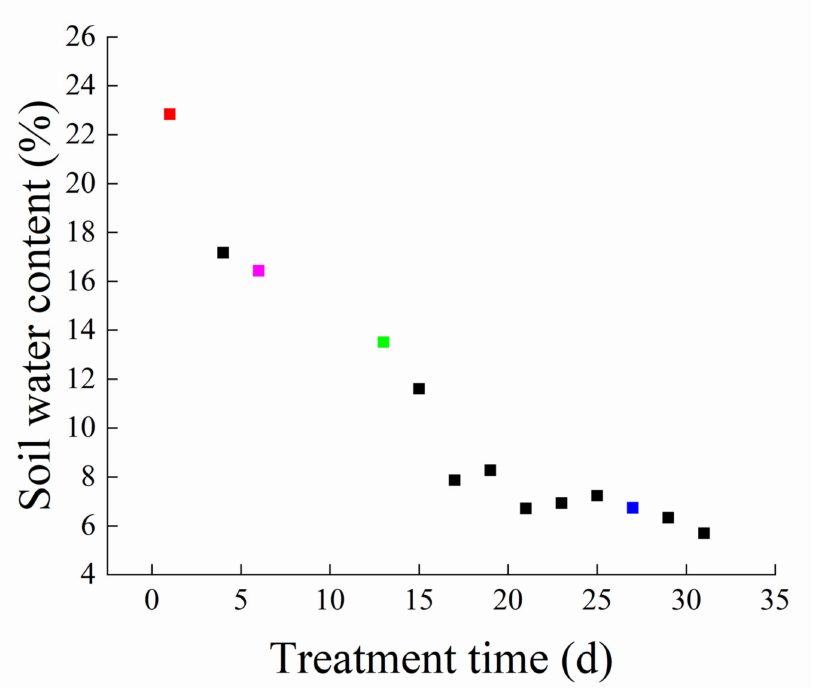
Figure 1. Changes in soil moisture under persistent drought. Red, pink, green, and blue squares represent 0 d, 6 d, 13 d, and 27 d samples,